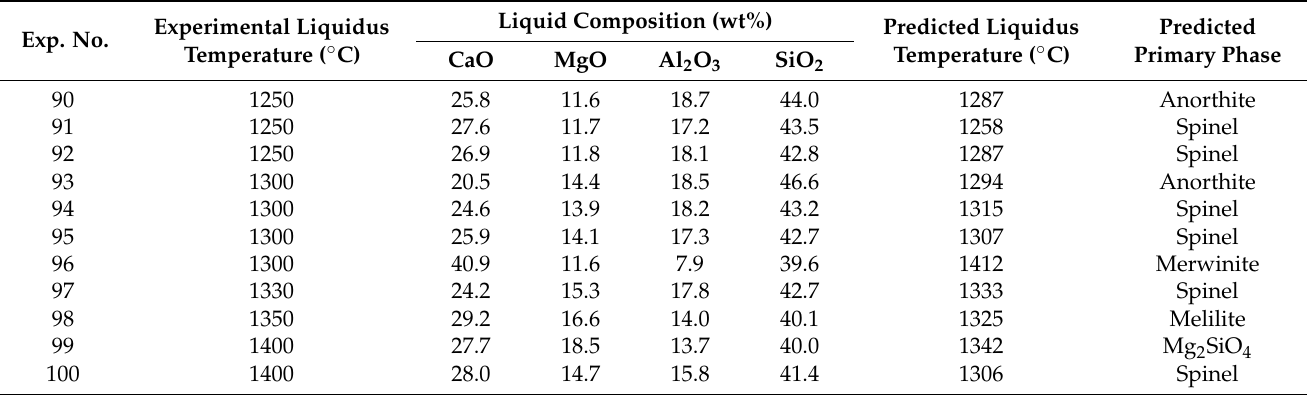
Table 2. Comparison of the experimental data with the FactSage predictions on primary phase and liquidus temperature, Mg 2 SiO 4 is the primary phase in all experiments.